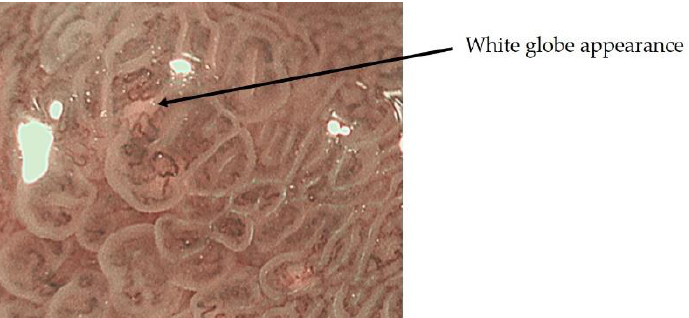
Figure 6. White globe appearance.